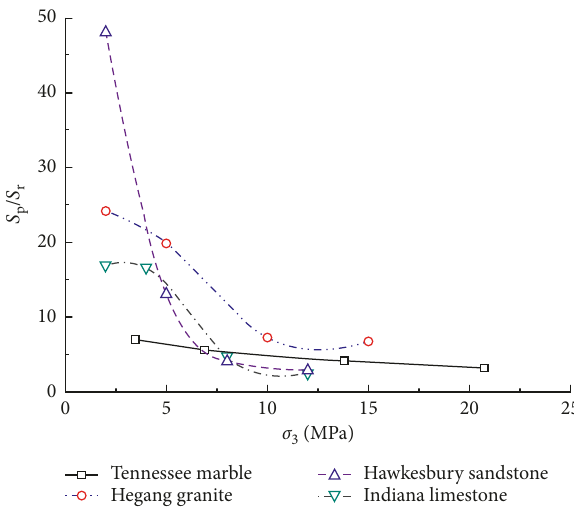
Figure 13: Relationships between S different types of the